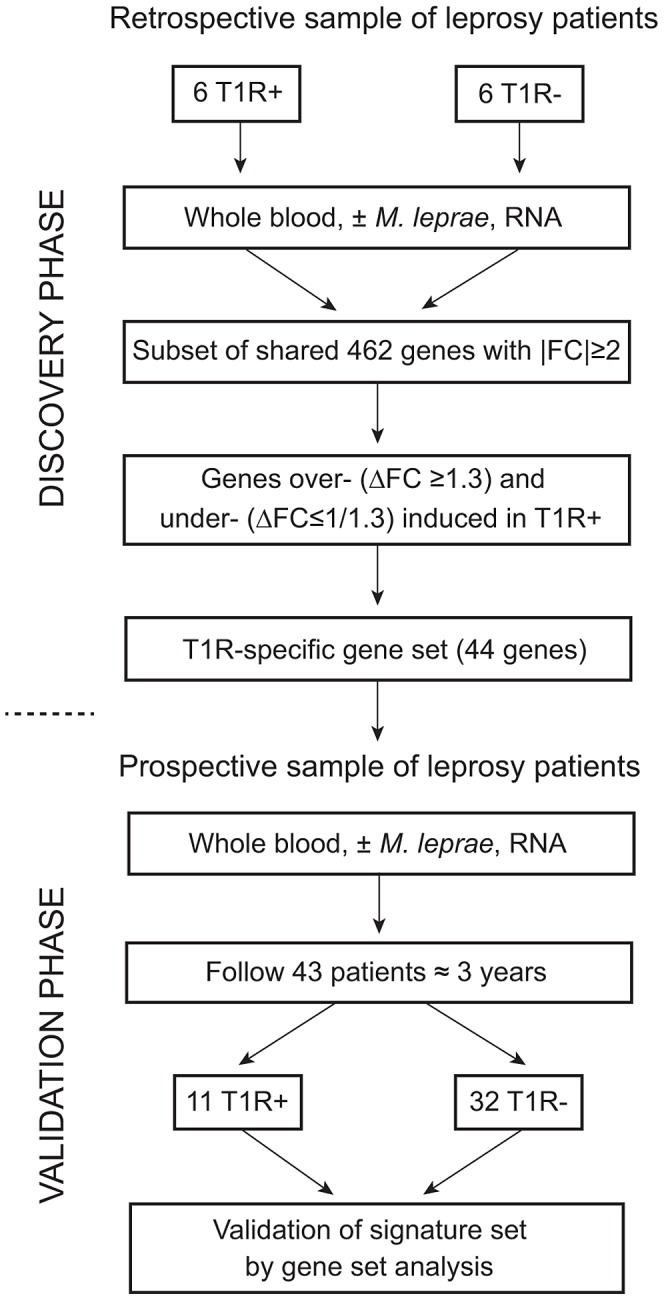
Work flow of the study.The study was subdivided into a discovery and a validation phase. In the discovery phase, we enrolled 12 leprosy patients of which six had developed T1R. All subjects had been cured of disease at least five years prior to being enrolled in the study. Whole blood of all subjects was subjected to M. leprae sonicate stimulation and 462 genes with an absolute fold change (|FC|)≥2 of gene expression were identified. From this set of genes we derived a subset of genes that were over- (ΔFC≥1.3) or under-stimulated (ΔFC≤1/1.3) in T1R patients. This subset of genes was termed the T1R-specific gene set. In the validation phase, we enrolled 43 leprosy patients and obtained RNA from whole blood assays at the time of enrolment. We followed these patients for at least 3 years and recorded 11 instances of T1R. We conducted a gene set analysis and validated the 44 gene T1R set in this group of T1R patients.